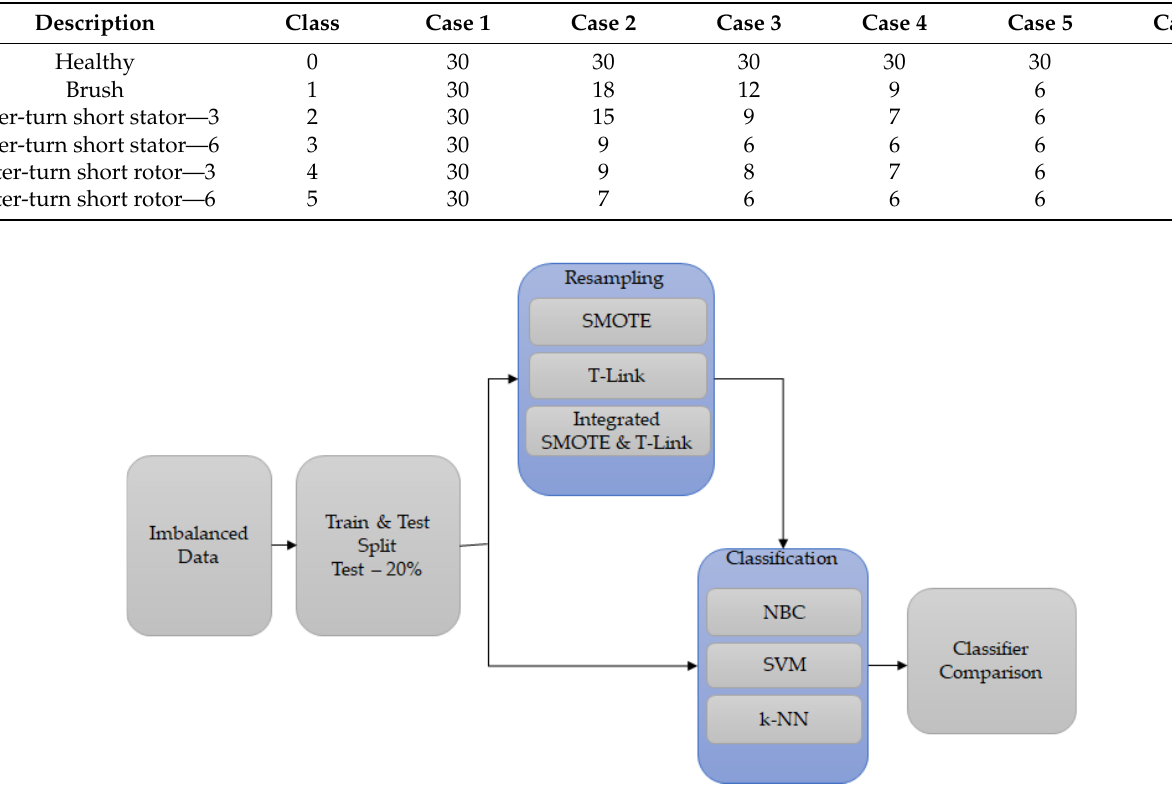
Figure 4. The method for WRIG imbalanced data.